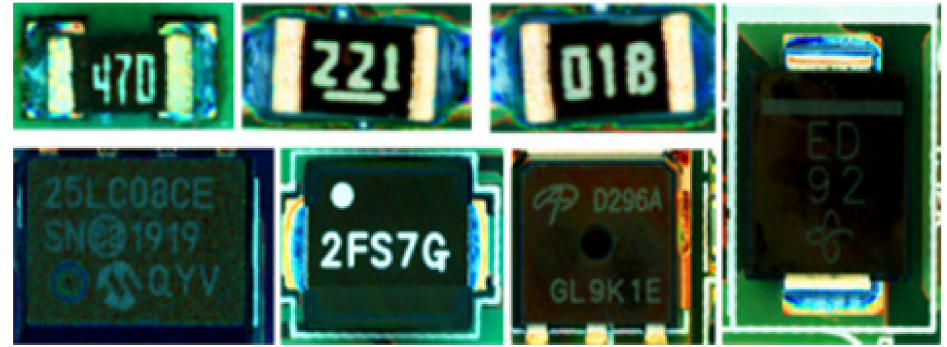
Figure 1. Examples of components attached to